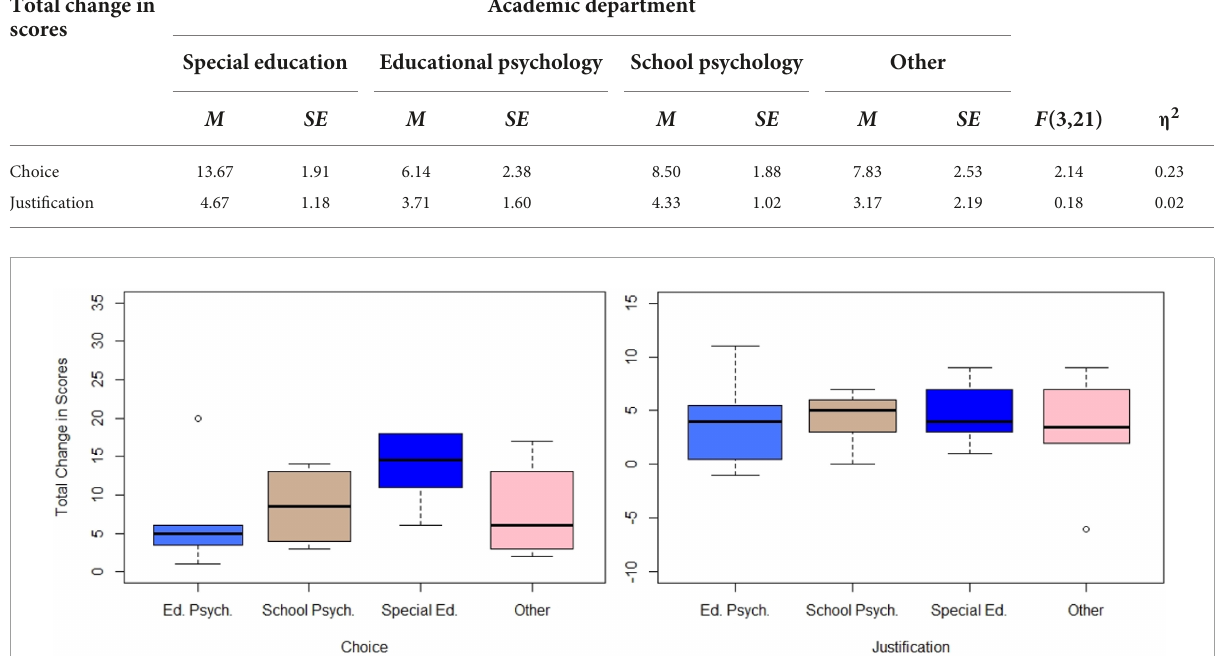
FIGURE5 Total change in scores for choice and justification of quantification technique across academic